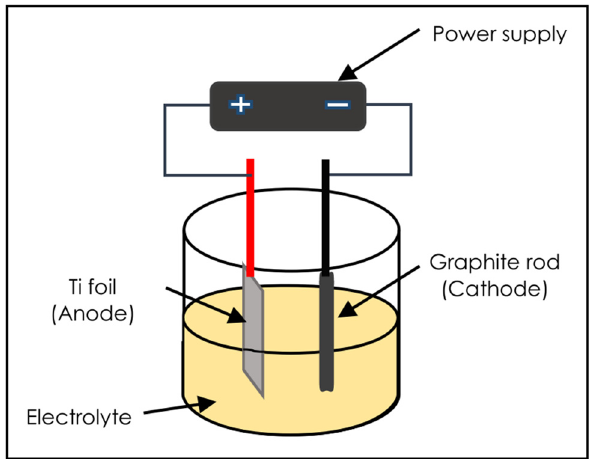
Figure 6: Schematic illustration of the AO process [ 77 ] . Copyright 2017, Journal